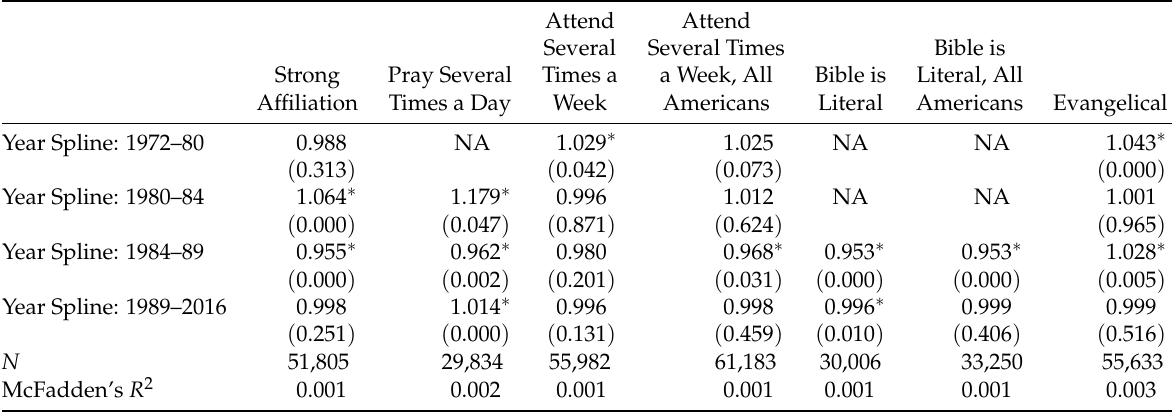
Table 2: Intense religion over time, with splines for observed periods of religious